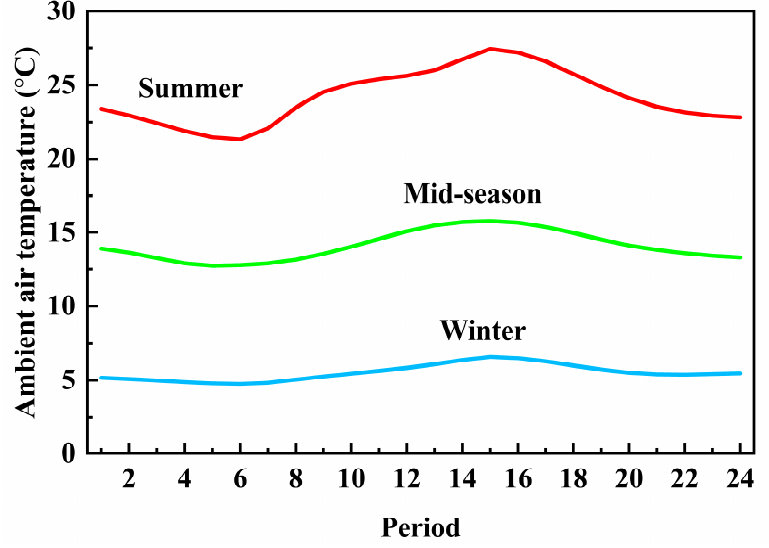
Figure 2. Ambient air temperature during the three typical days.